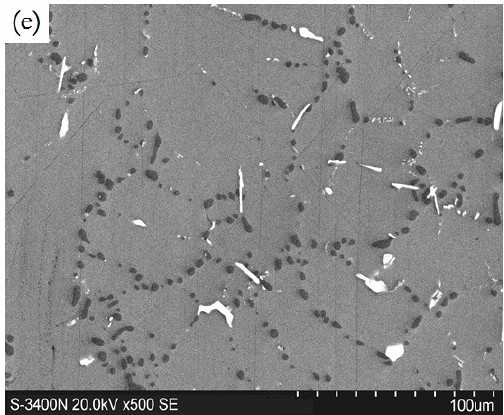
Figure 5. SEM images of the Ho-modified A356 alloys, ( a ) 0.2 wt.%, as-cast; ( b ) 0.3 wt.%, as-cast; ( c ) 0.4 wt.%, as-cast; ( d ) 0.2 wt.%, T6; ( e ) 0.3 wt.%, T6.